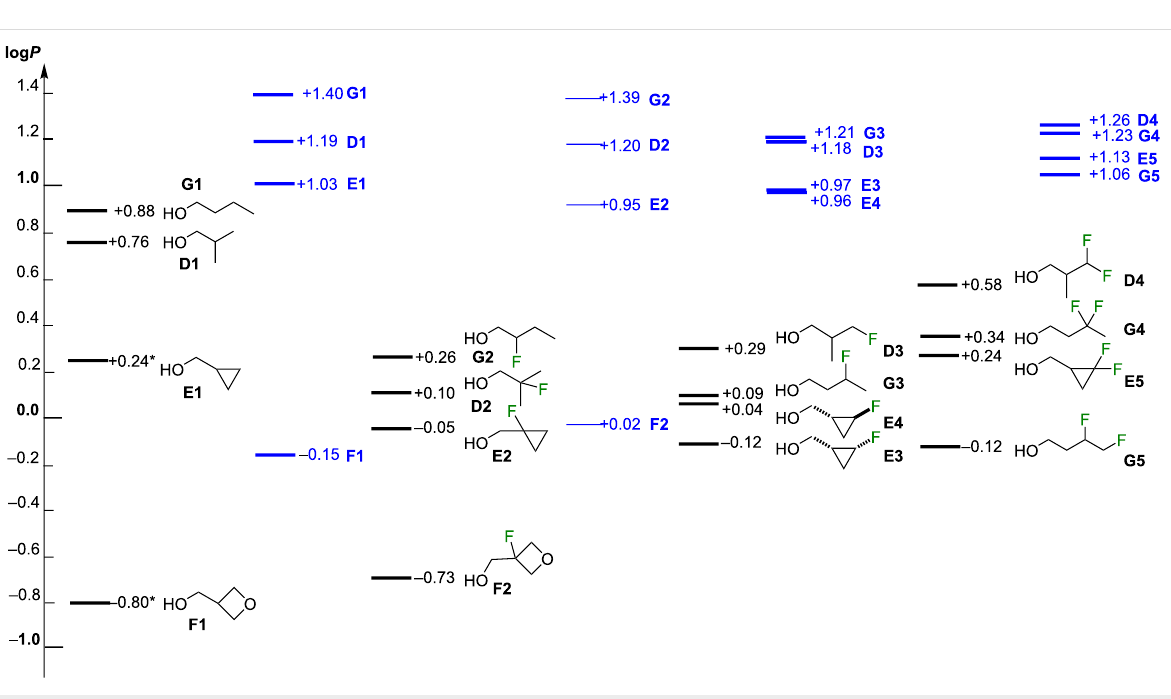
with the geminal difluorinated analogue. The typically ob- served lower lipophilicities of branched isomers vs their linear isomers are also observed for β -fluorohydrin containing